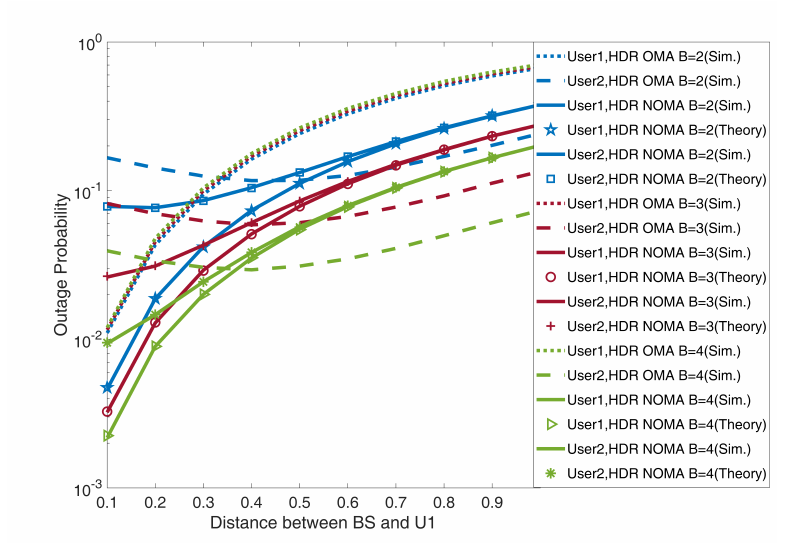
Figure 5. Outage probability versus distance of U1, i.e., UAV from BS for U 1 and U 2 under UAV − HDR based − NOMA and OMA